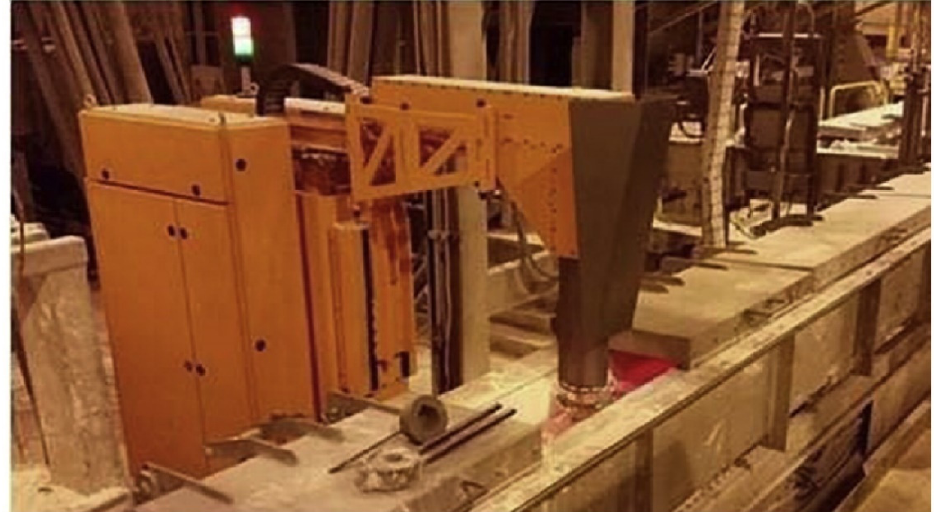
Figure 3. Molten aluminum monitoring industrial LIBS analyzer developed by Gudmundsson et